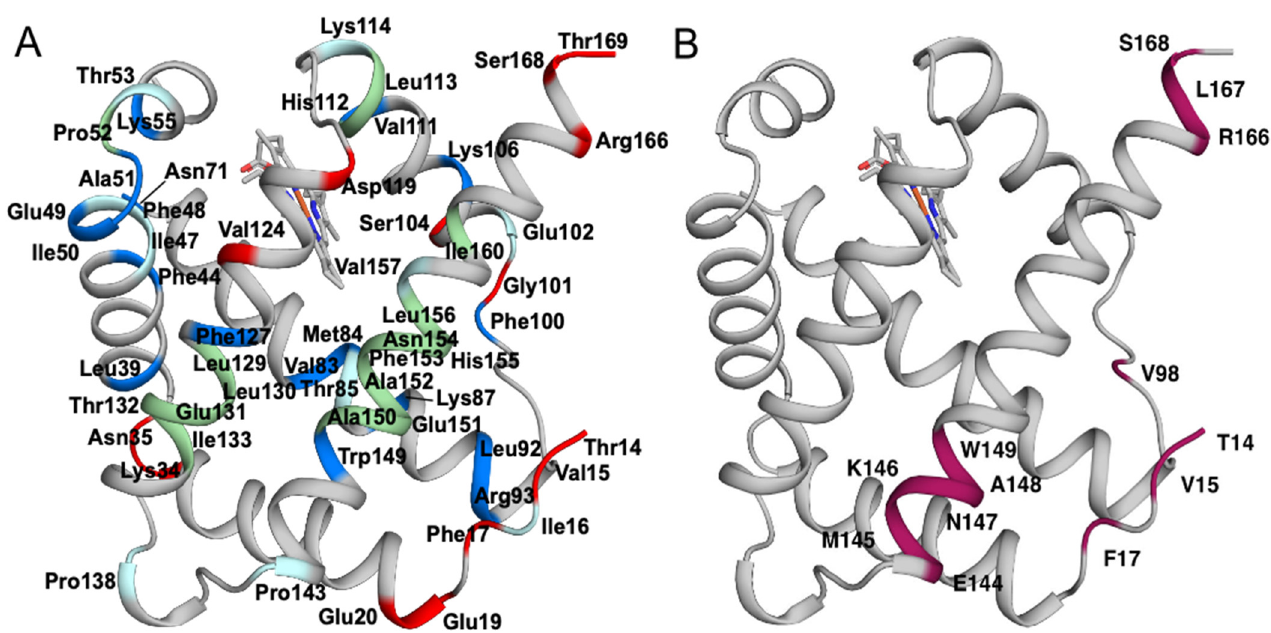
Figure 2. ( A ) High R 2 (blue), high R 1 (red), missing (green), and partial (cyan) assignments and ( B ) residues showing two conformations or line broadening (purple) color coded on the structure of BvPgb1.2. Table 1. List of residues with partial assignments and missing assignments. Partial